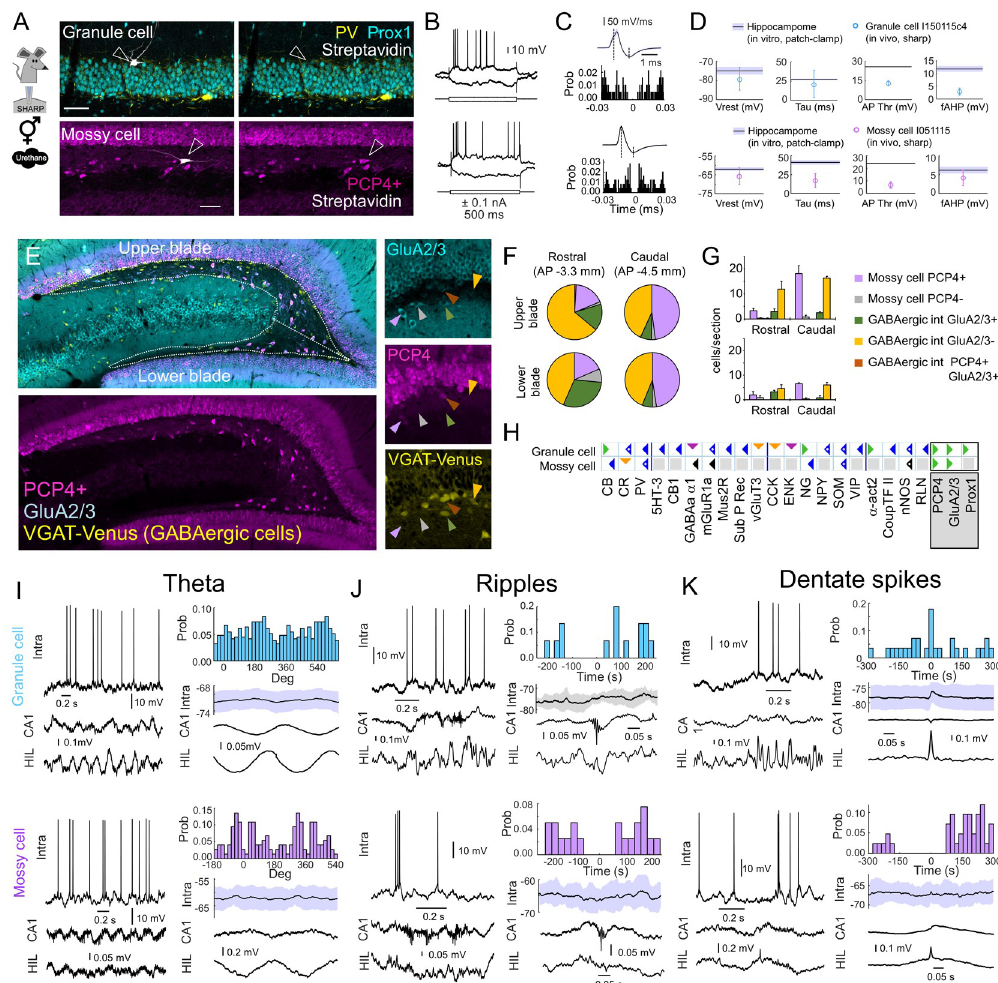
Fig 3. Oscillatory behavior and neurochemical profiling of DG cells. (A) Example of a granule cell (lower blade) and a mossy cell (upper blade) recorded intracellularly with sharp electrodes under urethane anesthesia, labeled with Neurobiotin, and identified with streptavidin for immunohistochemical colocalization with Prox1 and PCP4. ( B) Firing pattern responses of the granule and mossy cells were consistent with TSWB. ( C) Derivative of the action potential and the firing autocorrelogram of the granule and mossy cells. ( D) Membrane biophysics properties of granule and mossy cells recorded in vivo as compared with in vitro data from Hippocampome.org. ( E) Immunohistochemistry against GluA2/3 and PCP4 in VGAT-Venus transgenic rats. The right insets identify the different cell types (arrowheads, see color code in panel G). ( F) Proportion of cell types as evaluated by complementary expression of PCP4, GluA2/3, and VGAT. ( G) Quantification of different cell types. Note the colocalization between GluA2/3, PCP4, and VGAT validates bona fide markers of mossy cells. ( H) Updated Hippocampome.org molecular markers for granule and mossy cells (green triangle: positive; blue triangle: negative; orange triangle: positive–negative due to species/protocol differences; magenta triangle: positive–negative due to subcellular expression differences). ( I) Firing patterns of the granule cell and the mossy cell shown in A during theta oscillations. Left, Representative traces from each cell. Right, Mean firing histogram (top), membrane potential (middle), and LFP events (bottom) for each cell. ( J) Same for SWR. ( K) Same for DS. The underlying data can be found in S1 Data. α -act2, alpha actinin 2; CB, calbindin; CB1, cannabinoid receptor type 1; CCK, cholecystokinin; CoupTF II, chicken ovalbumin upstream promoter transcription factor II; CR, calretinin; DG, dentate gyrus; DS, dentate spikes; ENK, enkephalin; GABAa α 1, GABA-a alpha 1 subunit; GluA2/3, AMPA receptor 2/3; HIL, hilus; LFP, local field potential; mGluR1a, metabotropic glutamate receptor 1 alpha; Mus2R, muscarinic type 2 receptor; NG, neurogranin; nNOS, neuronal nitric oxide synthase; NPY, neuropeptide-y; PCP4, Purkinje cell protein 4; Prox1, prospero homeobox protein 1; PV, parvalbumin; RLN, reelin; SOM, somatostatin; Sub P Rec, substance P receptor; SWR, sharp-wave ripple; TSWB, transient slow wave bursting; VGluT3, vesicular glutamate transporter 3; VIP, vasoactive intestinal peptide; 5HT-3, serotonin receptor 3.